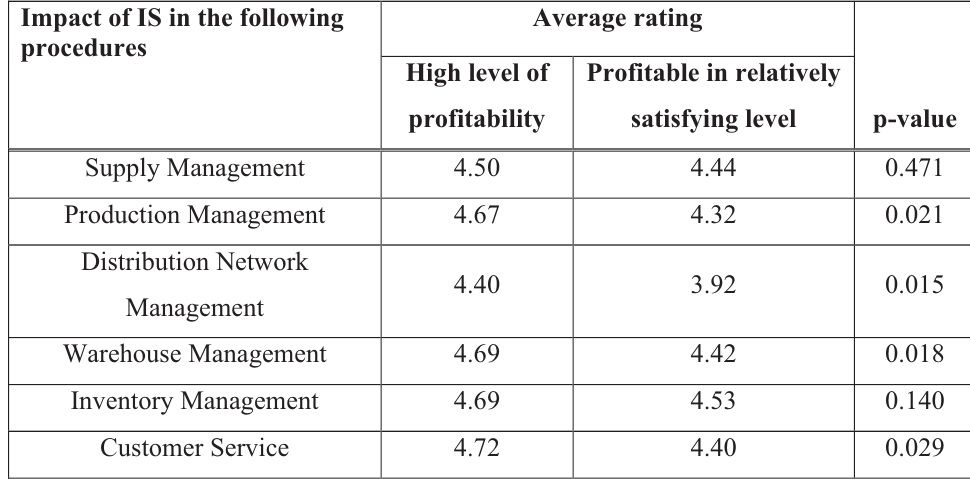
Figure 5. Impact of IS adoption—Level of profitability.